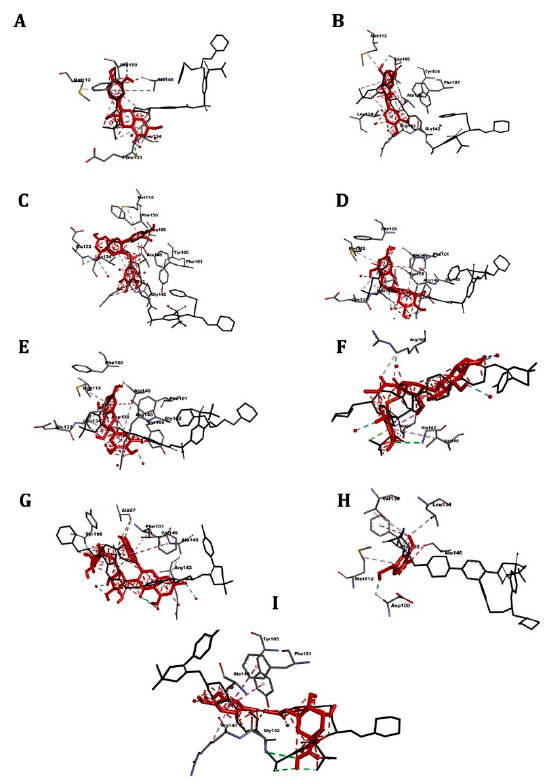
In red, tested molecule